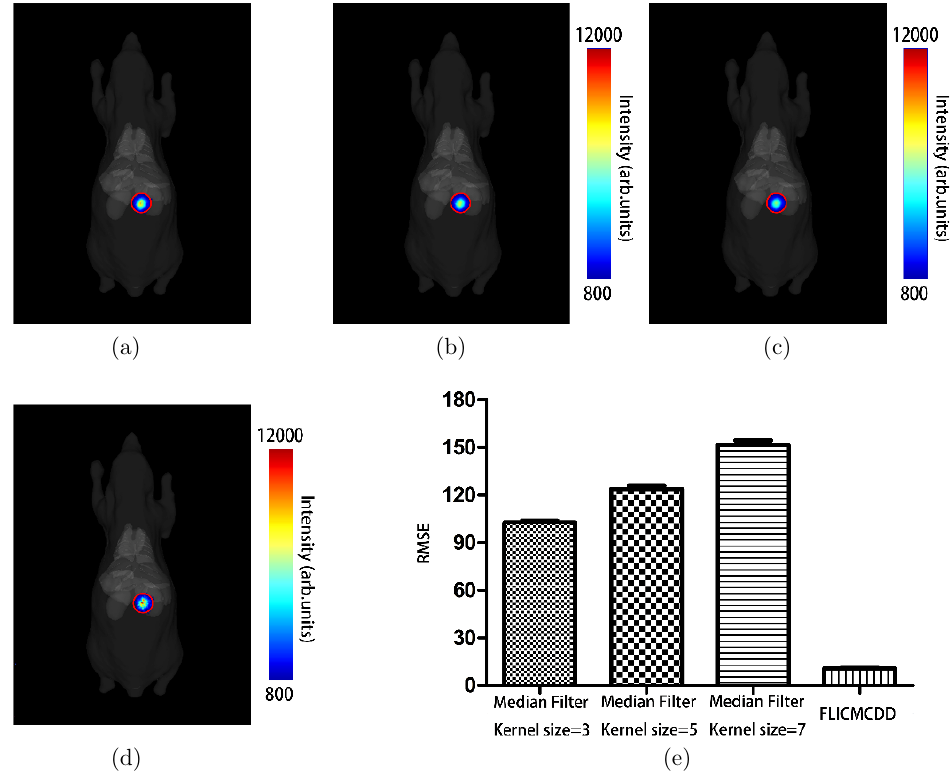
Fig. 3. A comparison of RMSE value between median ¯lter and FLICMCDD: (a) – (c) results of median ¯lter with di®erent kernel sizes (size ¼ 3, 5 and 7, respectively); (d) result of FLICMCDD and (e) comparison of RMSE value of ROI for the FLICM and median